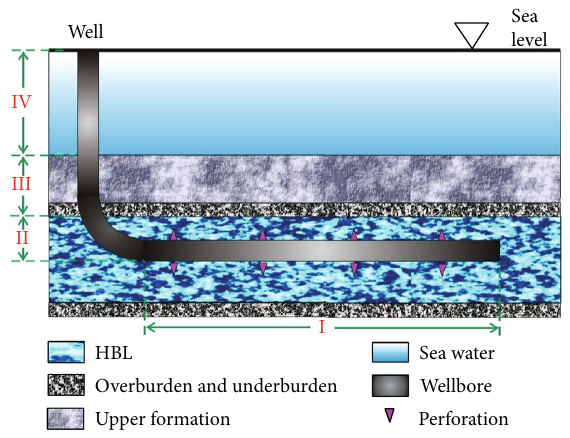
Figure 1: Natural gas hydrate reservoir horizontal well depressurization